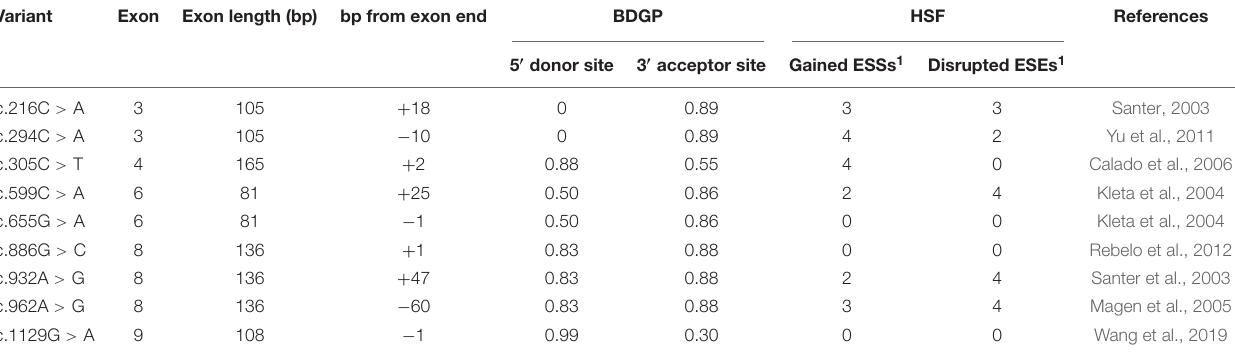
TABLE 1 | SLC5A2 exonic variants selected from this study and their effects. Variant